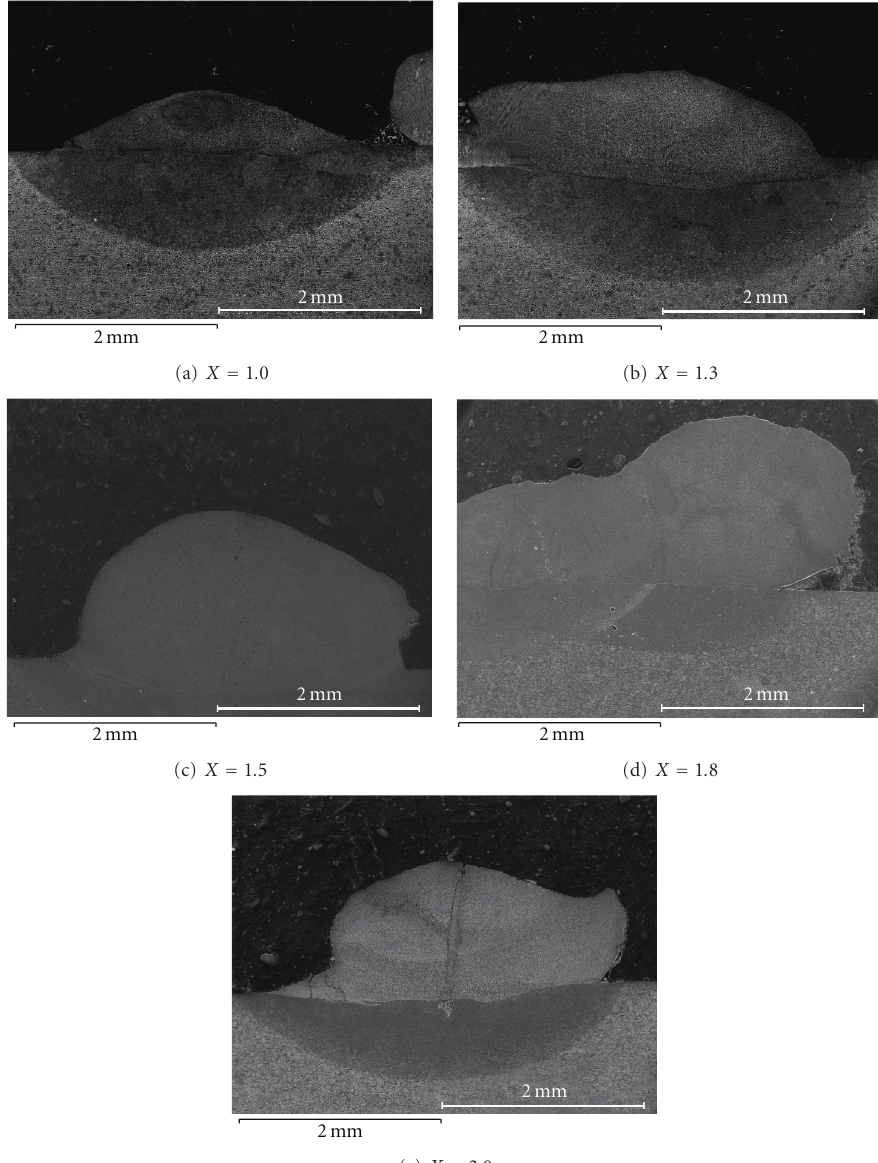
Figure 1: Macroscopic SEM figures of Al X FeCoNiCuCr High-entropy alloys under di ff erent X values at (a) X = 1, (b) X = 1 . 3, (c) X = 1 . 5, (d) X = 1 . 8, and (e) X = 2 .